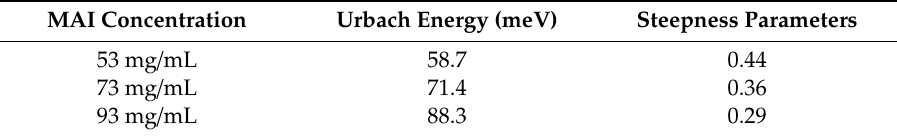
Table 1. The Urbach energy and steepness parameters of absorption data. MAI Concentration